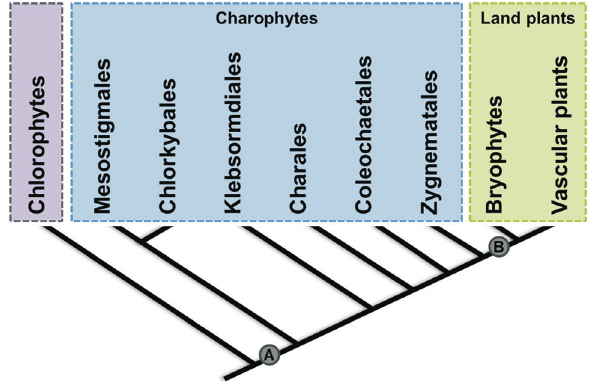
Figure 9 - Emergence and expansion of GRF family in Viridiplantae. (A) GRF emerged in a charophyta ancestor previous to Mesostigmales. (B) The expansion of the GRF family occurred in land plants. Diagram of the relationships between algae and plant lineages is based on data already published (Morris et al. ,